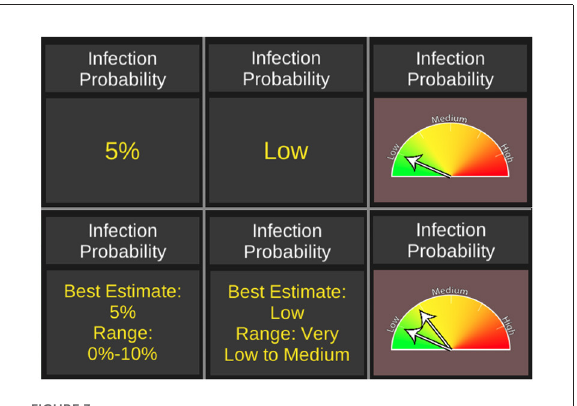
FIGURE3 A sample of treatments used in the experiments. Numeric, linguistic, and graphical messaging of 5% (low) infection risk in English (top) . Same messaging under uncertainty treatment (bottom)